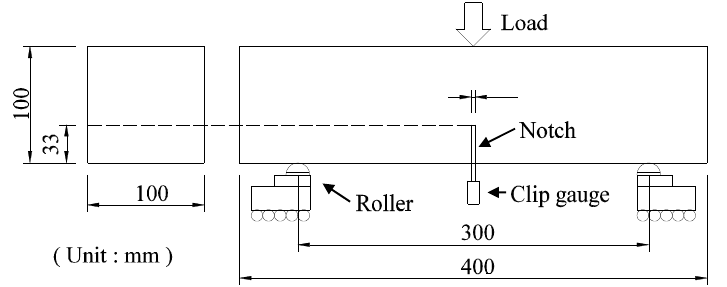
Figure 1. Schematic of the experimental setup.